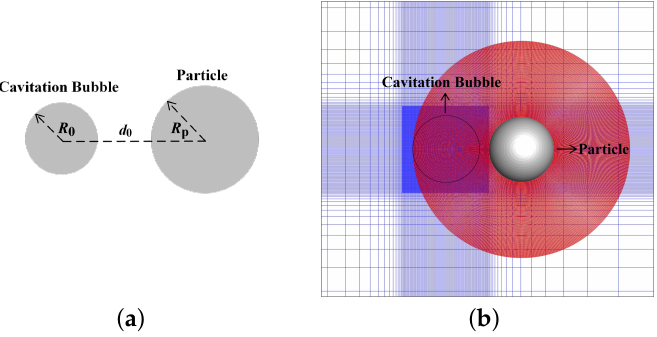
Figure 1. ( a ) Schematic showing the configuration of a collapsing bubble and a spherical particle; ( b ) 2D illustration of an overset mesh system: the background mesh (blue) and overset mesh